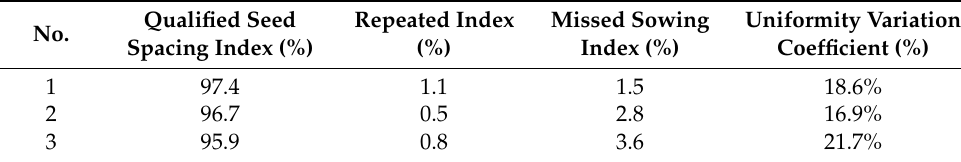
Table 8. Seed singulation performance of the field